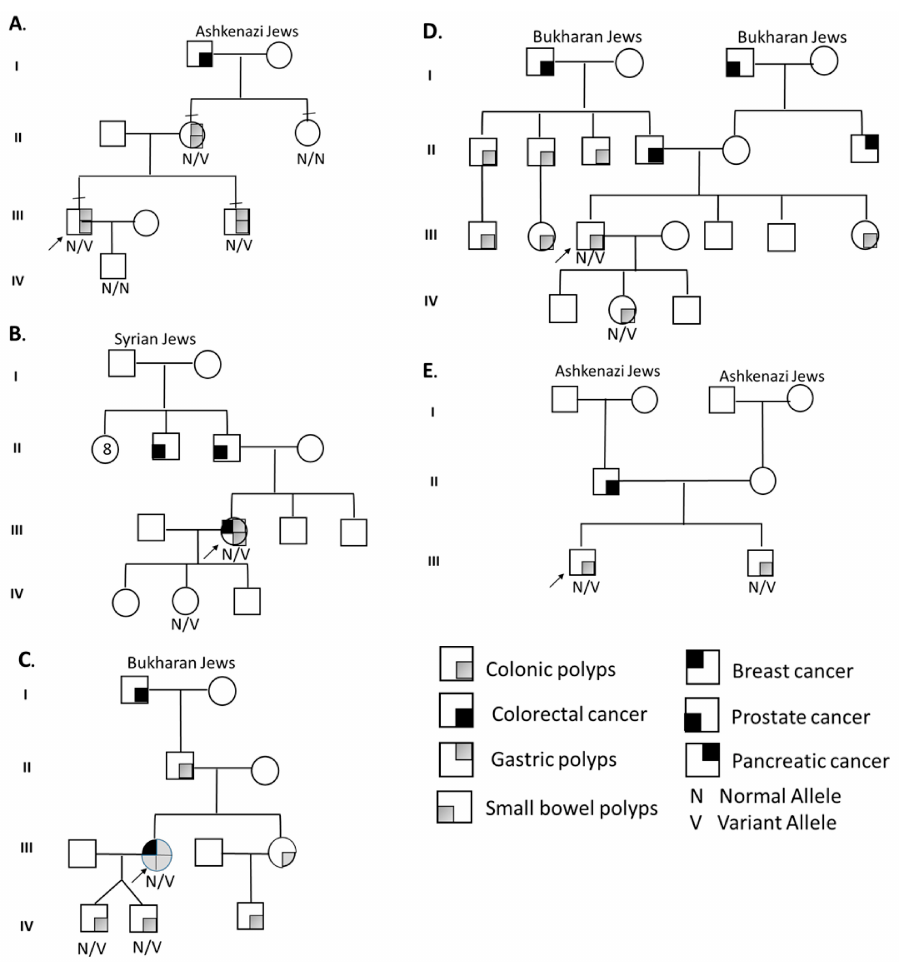
Figure 2. Pedigrees and segregation analysis results of the study families. (( A – E ) correspond to probands order).